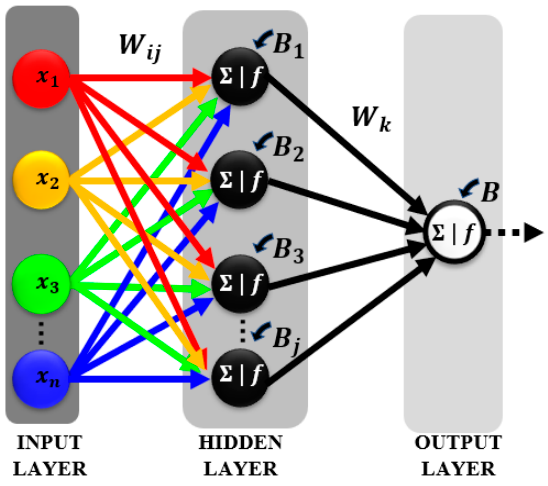
Figure 1. General network architecture of a typical ANN.